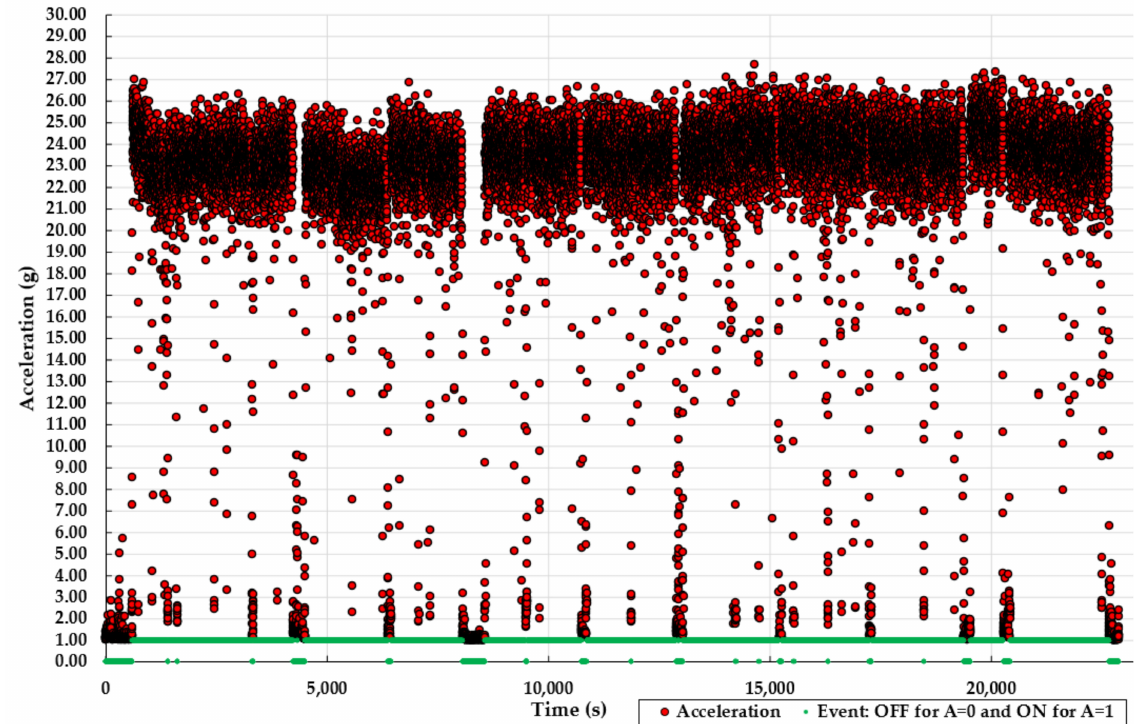
Figure A3. Description of datasets used in the testing phase of the MLPs: TEST_S1. Note: conventionally, a value set at 0 (A = 0) indicates the events documented as OFF, while a value set at 1 (A = 1) indicates the events documented as